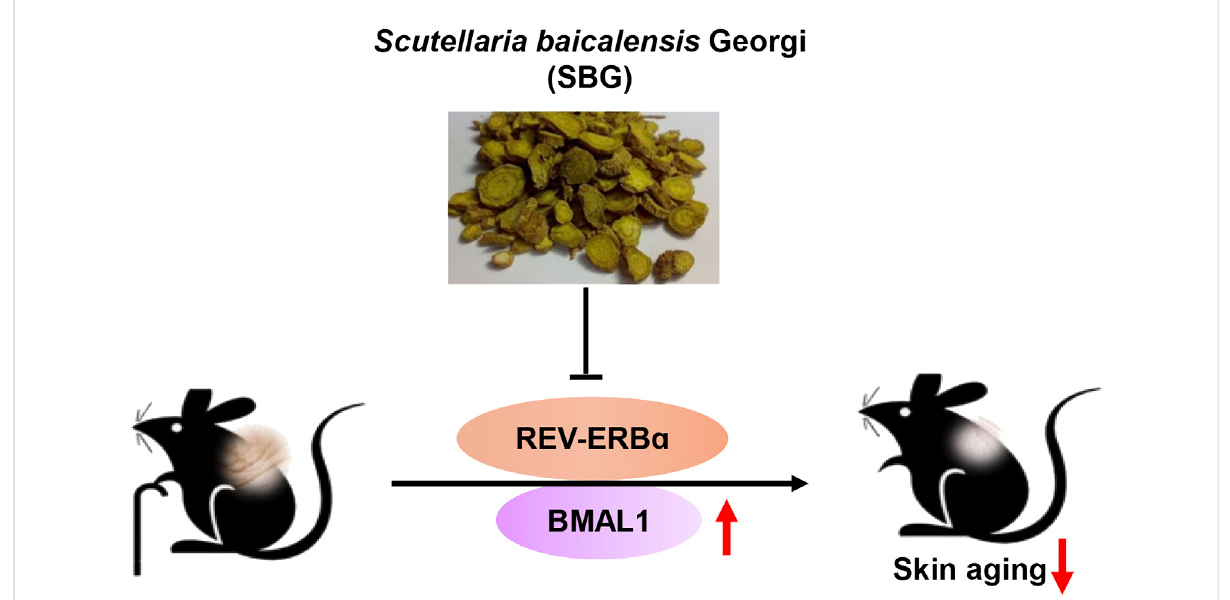
FIGURE 10 Schematic diagram showing the proposed mechanism for anti-skin aging effect of